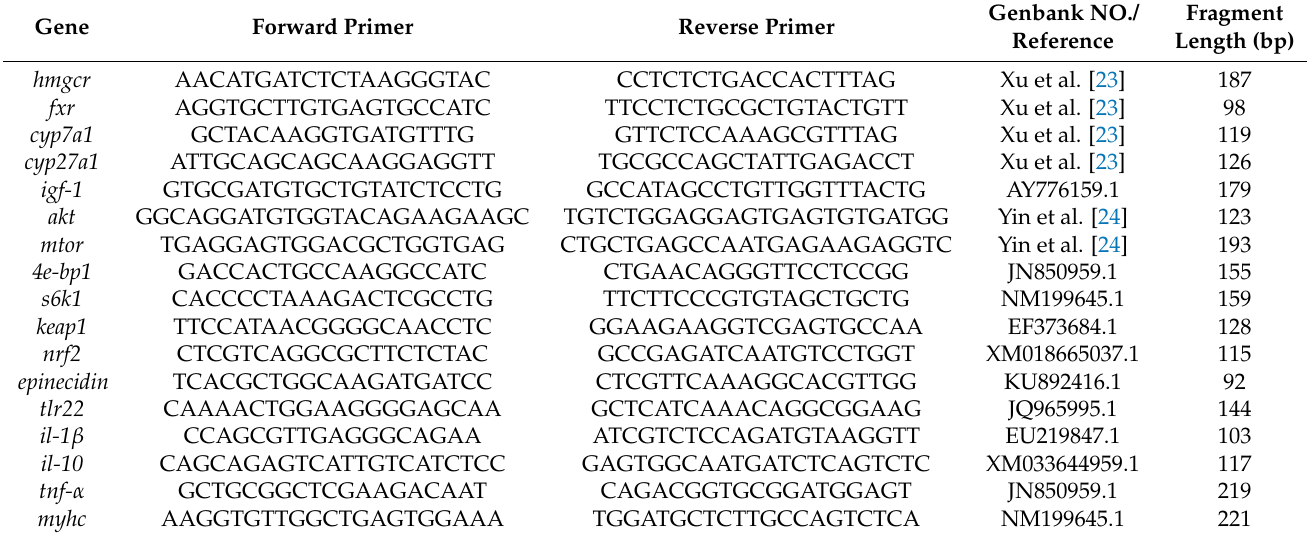
Table 2. Sequence of the primers used for real-time